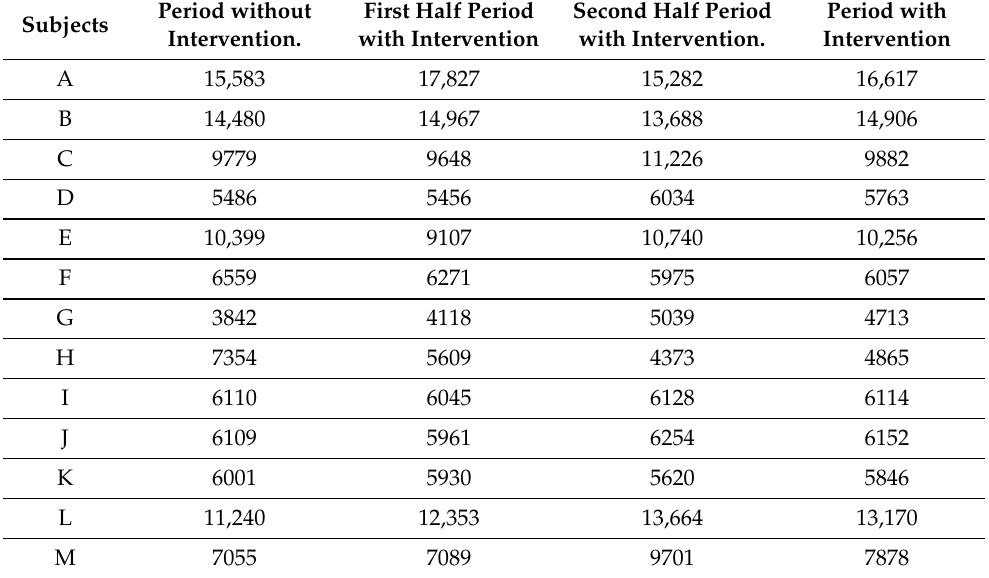
Table 6. Results of steps for each